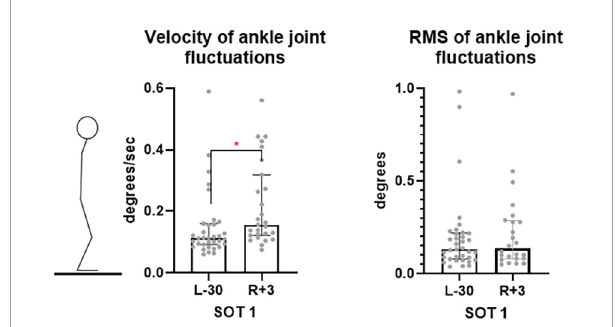
FIGURE8 Ankle joint fluctuation velocity is SOT1 test. L-30 – 30 days before launch, R + 3 – 3rd day of recovery period after